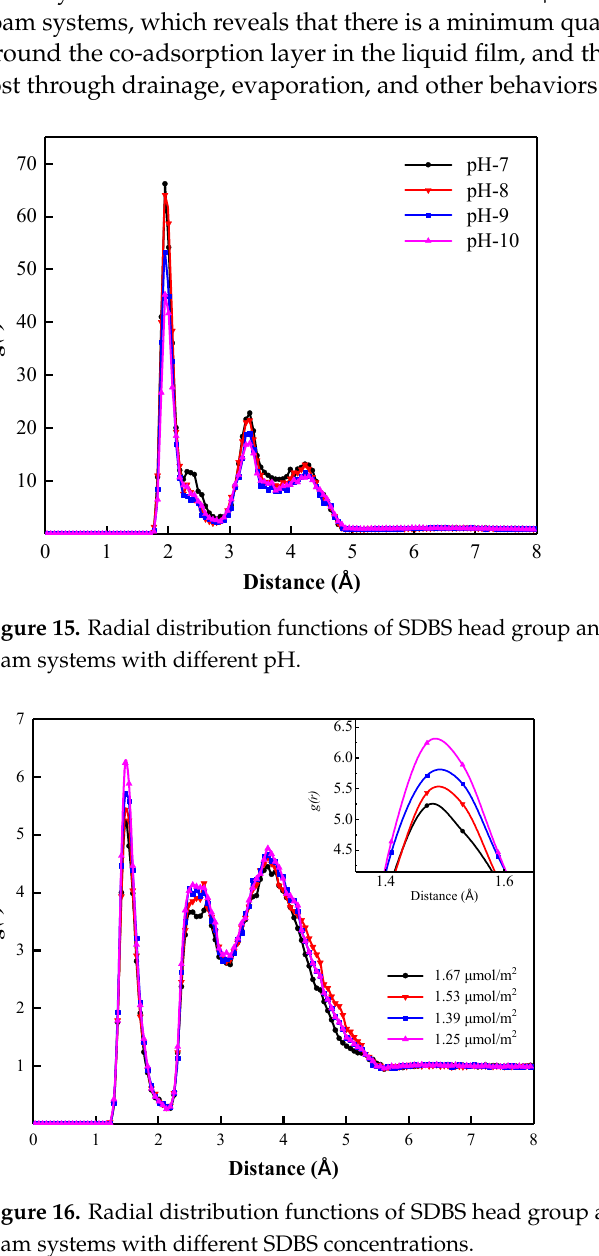
Table 4. Coordination numbers of water molecules in the hydration shells of foam systems with different SDBS concentrations. Foam System Coordination Numbers of Water Molecule 1.67 µmol/m²